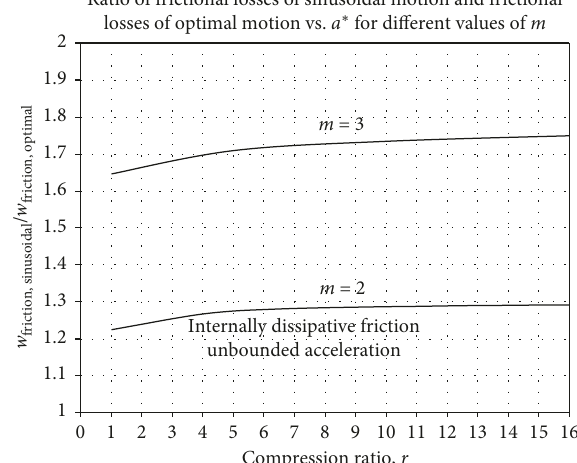
Figure 9: Sensitivity to compression ratio of reduction in frictional losses. Calculations are for unbounded acceleration. Ordinate is dynamic frictional losses for conventional piston motion relative to that for optimal piston motion, for internally dissipative friction. Abscissa is the compression ratio. The two curves are for different frictional exponents m and show the marked dependence on m .